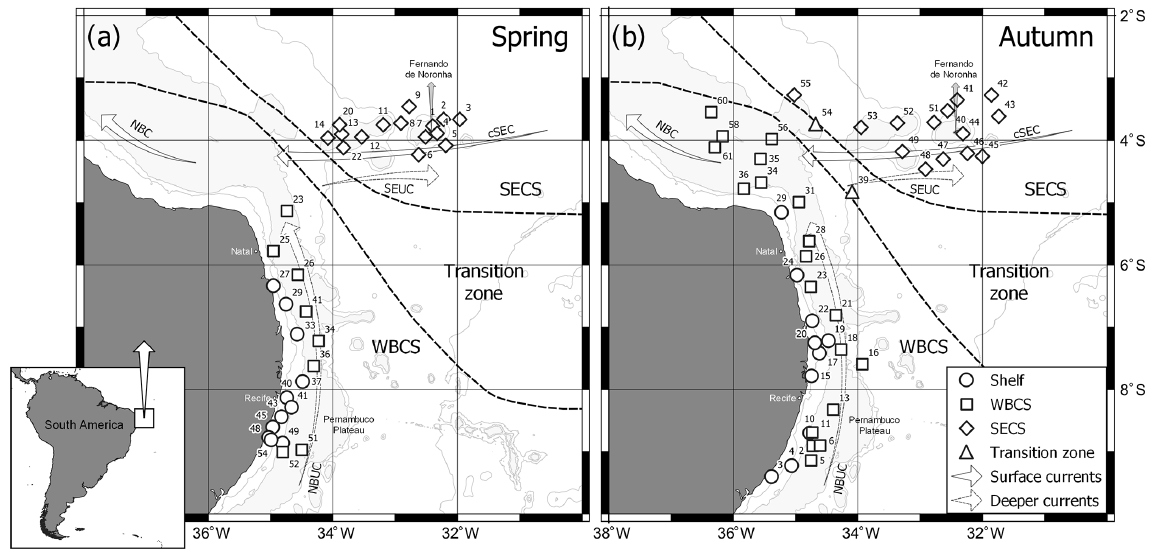
Figure 1. Geographic location of the study area in the western tropical South Atlantic, showing the sampled stations during (a) spring 2015 and (b) autumn